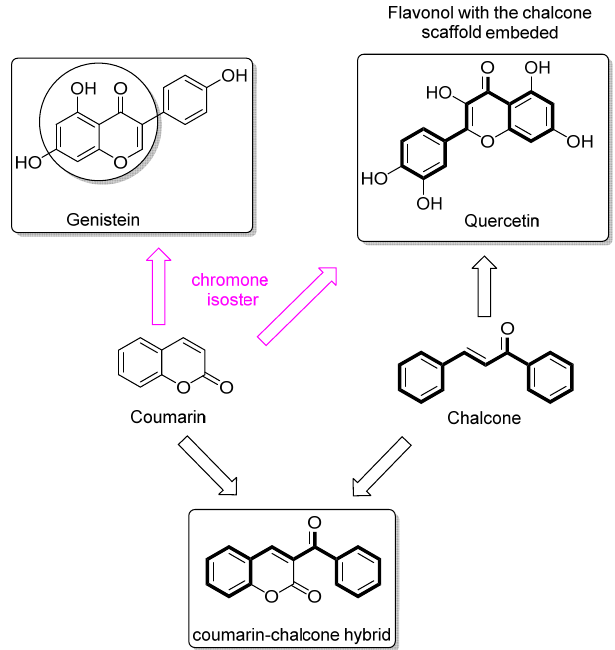
Figure 1. Rational design of coumarin–chalcone hybrids.